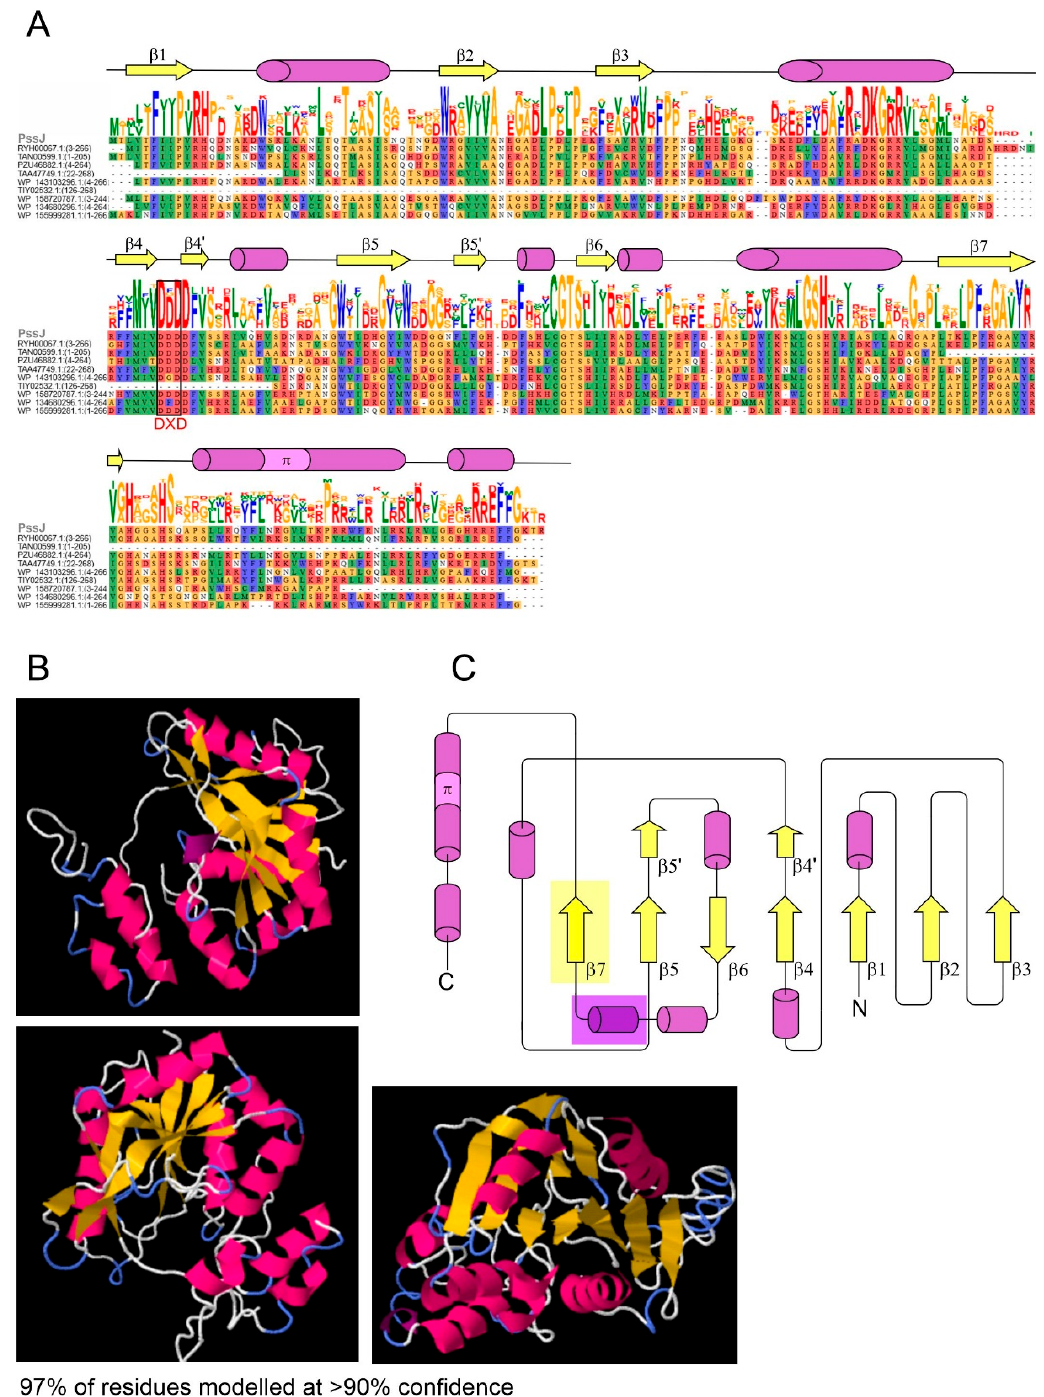
Figure 2. PssJ structure modeling. ( A ) Multiple alignment of amino acid sequences of PssJ homologs listed in Table S1 (the PssJ sequence covers amino acids 1–699). Predicted secondary structures are shown above the sequence logo. β -strands are shown in yellow and helices are marked in purple and pink. The frame indicates the position of the DXD motif found in GT-A glycosyltransferases. The ribbon diagram of the PssJ structure modeled with Phyre2 is shown in ( B ) and the secondary structure topology based on this and other secondary structure predictions is shown in ( C ). The H-DROP domain linker prediction indicated the presence of a linker between 178–197 aa in the PssJ sequence (purple shadow). No typical transmembrane segments were predicted, in contrast to the region of membrane interaction/association (yellow shadow).